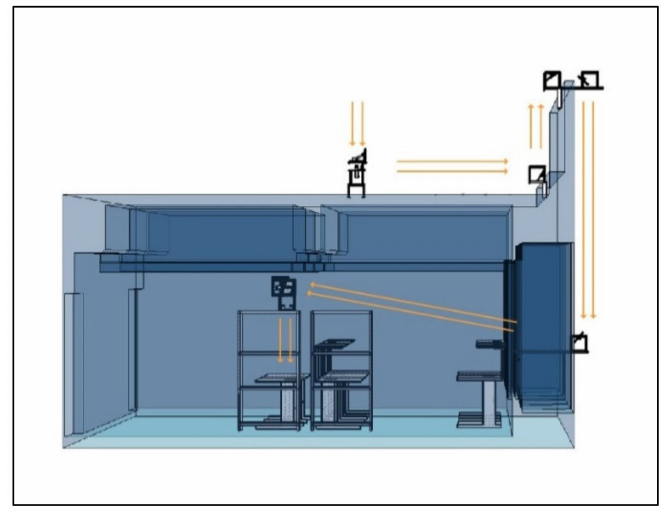
Figure 6. Perspective view of the field.